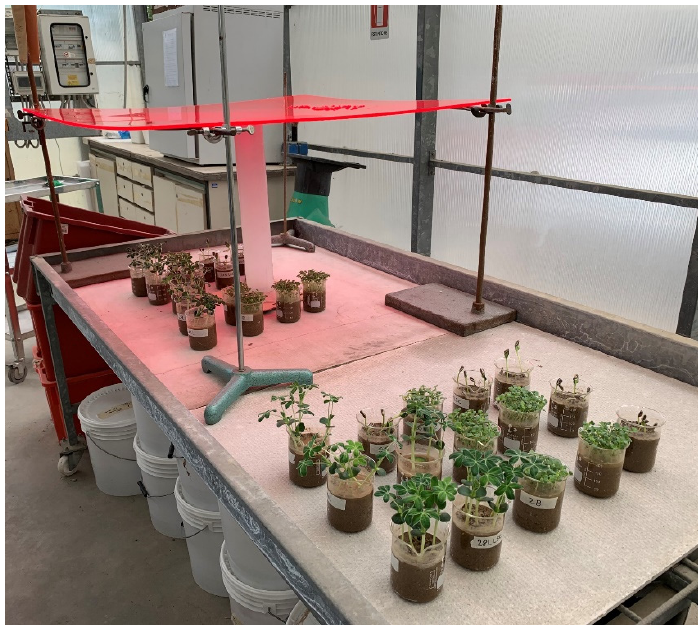
Figure 4. Picture of the experiments inside the greenhouse.